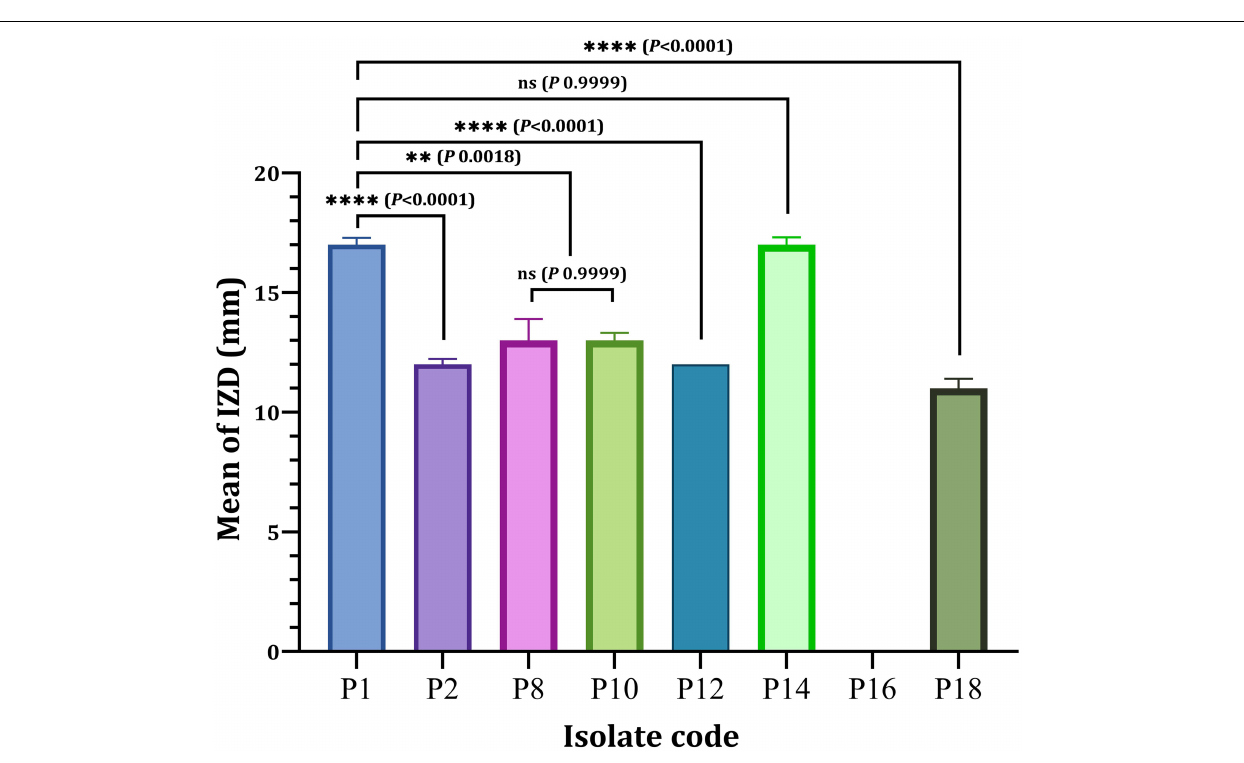
as compared to P 2 (12 ± 0.23 mm), P 12 (12 ± 0.00 mm) and P 18 (11 ± 0.40 mm). In contrast, MDRP8 and MDRP10 showed no significance in terms of IZD ( P < 0.9999) ( Figure 3